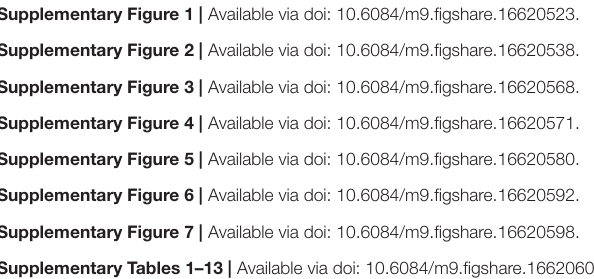
Supplementary Figure 1 | Available via doi: 10.6084/m9.figshare.16620523. Supplementary Figure 2 | Available via doi: 10.6084/m9.figshare.16620538. Supplementary Figure 3 | Available via doi: 10.6084/m9.figshare.16620568. Supplementary Figure 4 | Available via doi: 10.6084/m9.figshare.16620571. Supplementary Figure 5 | Available via doi: 10.6084/m9.figshare.16620580. Supplementary Figure 6 | Available via doi: 10.6084/m9.figshare.16620592. Supplementary Figure 7 | Available via doi: 10.6084/m9.figshare.16620598. Supplementary Tables 1–13 | Available via doi: